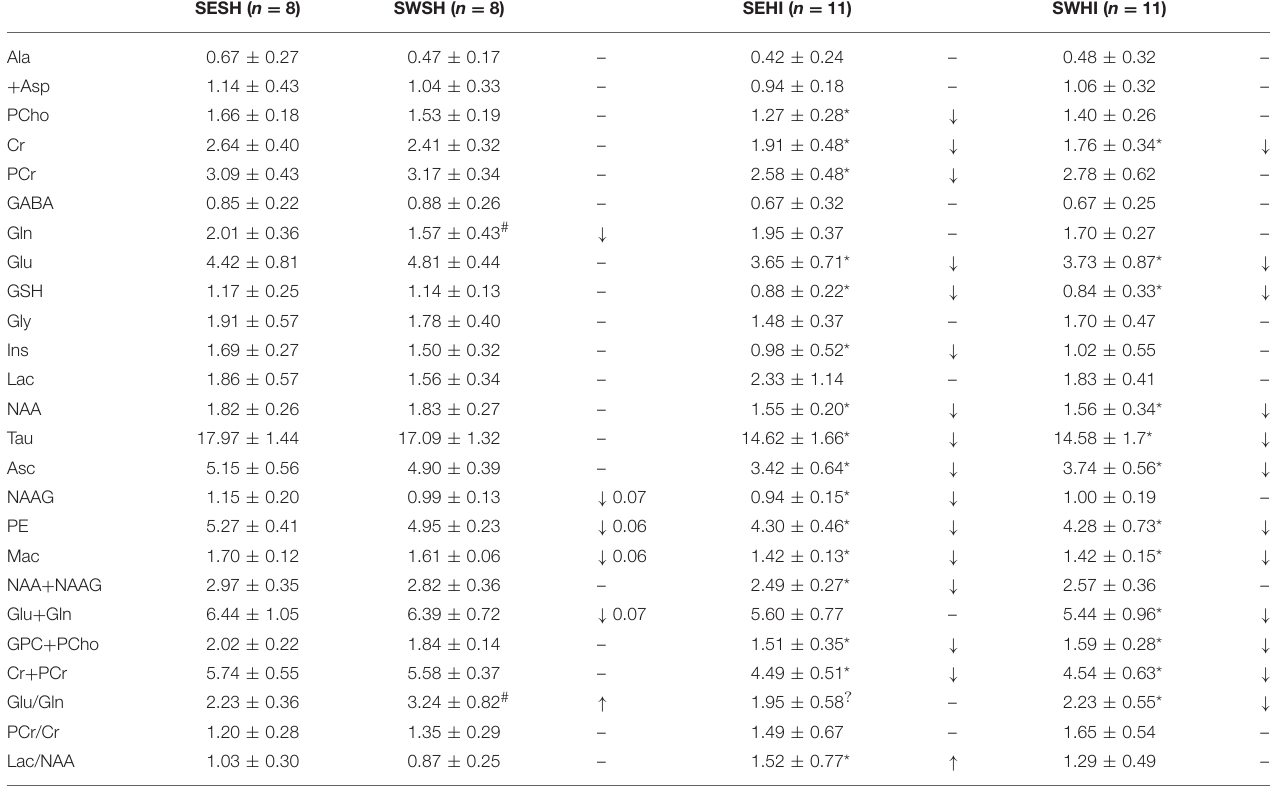
TABLE 2 | Concentrations ± SEM for the metabolites in the [1H]